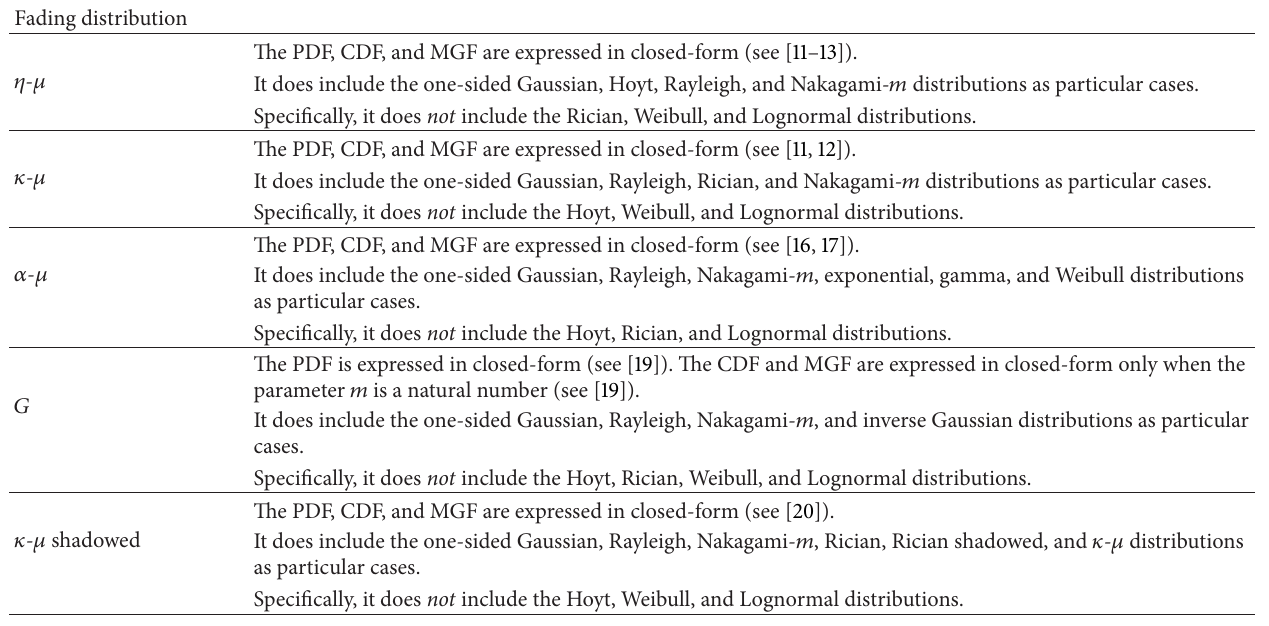
Table 1: Relevant statistical information on the novel fading